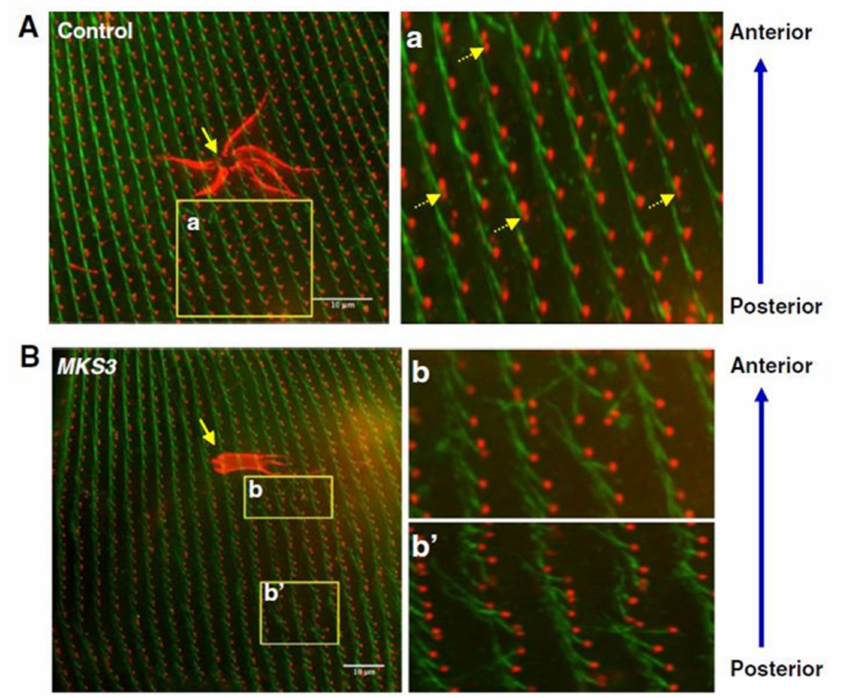
Figure 12. Chaotic orientation of the striated rootlet of MKS3 -depleted cells. Control cells ( A ) and MKS3 -depleted cells ( B ) were stained with anti-Glu- α -tubulin (red; basal bodies) and anti-striated rootlets (SRs) (also called anti-kinetodesmal fibers; green). Yellow arrows in ( A ) and ( B ) indicate the contractile vacuoles on the dorsal surface of these cells. SRs project from the basal bodies. In two basal body units, SRs project only from the posterior basal body ( a ; dotted yellow arrows). SRs project toward the anterior of the cell in a highly organized manner along the basal body row (kinety). Cells depleted of MKS3 show chaotic organization of the SRs, which project in every direction ( b and b ’). Scale bar: 10 µ m. Reproduced from [12], with